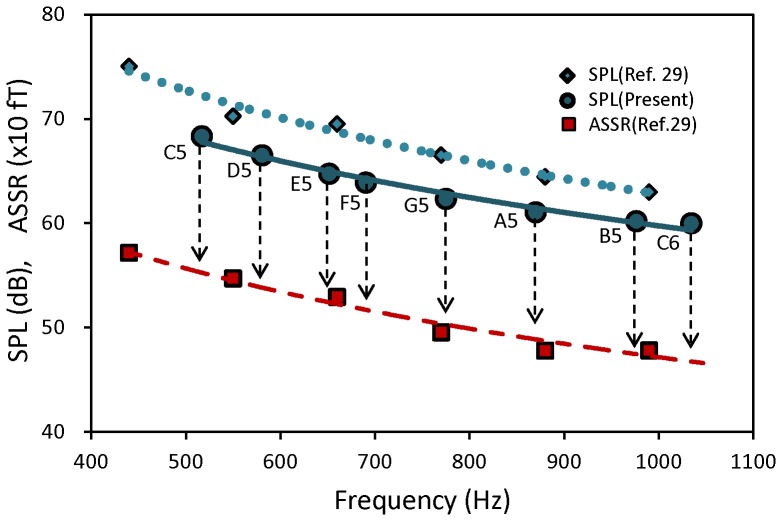
Sound pressure levels (SPL) in dB of stimulus AM tones used in a separate [29] and present studies.Dotted and solid lines represent approximation curves of logarithmic dependence on the carrier frequency. Also shown are magnitudes of ASSR elicited by the AM tones in [29], from which the variation of ASSR magnitude with the pitch of C-major key was estimated (vertical broken lines).